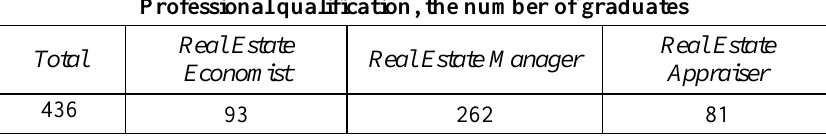
Table 5. The Number of Graduates at RTU of the Professional Bachelor’s